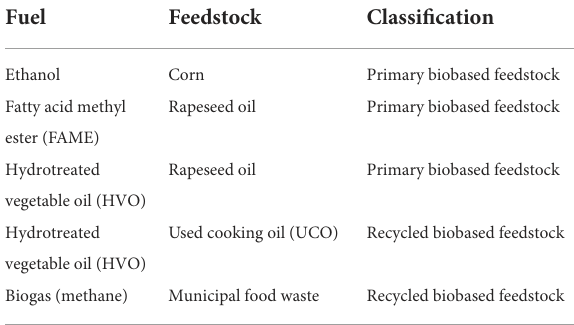
TABLE 1 Fuel production pathways